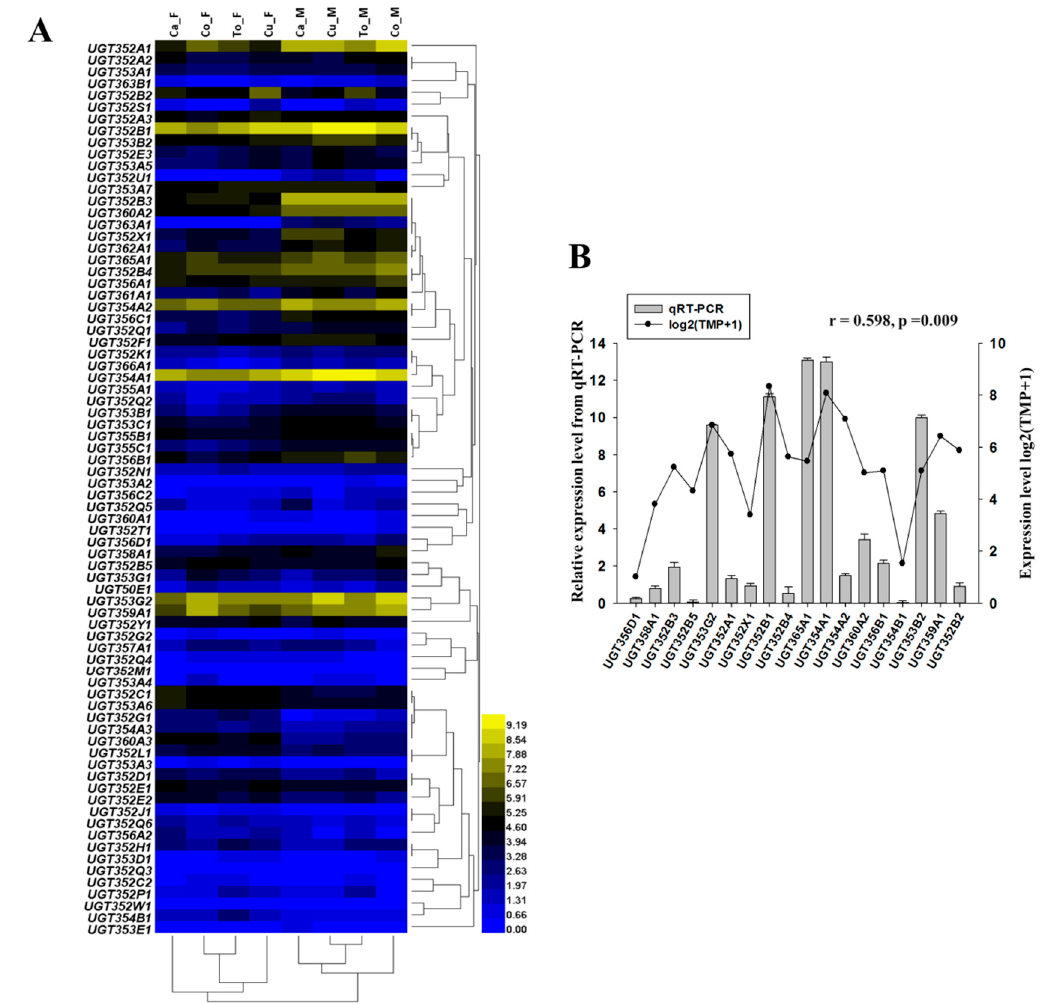
Figure 4. Expression profiling of UGT genes in MEAM1 was assessed using transcriptome data and RT-qPCR. ( A ) Expressions profiles of UGT genes in male and female adults that fed on four different host plants. The codes on the left are the gene ID numbers of the 76 UGTs in B. tabaci MEAM1. The mRNA levels, as represented by log2 (TPM + 1) values, are shown in the gradient heat map with colors ranging from blue (low expression) to yellow (high expression). Ca_F, females reared on cabbage; Ca_M, males reared on cabbage; Cu_F, females reared on cucumber; Cu_M, males reared on cucumber; Co_F, females reared on cotton; Co_M, males reared on cotton; To_F, females reared on tomato; To_M, males reared on tomato. ( B ) mRNA expressions of selected B. tabaci MEAM1 UGT genes by RT-qPCR. The bars represent expression level of B. tabaci MEAM1 UGT genes relative to the UGT352X. Data are presented as means ± SE. Spots indicated log2 (TMP + 1) values of UGT genes in Ca_F. Correlation between RNA-seq and RT-qPCR were tested using SPSS with Pearson and two-tailed test, r , Pearson correlation; p , significant.